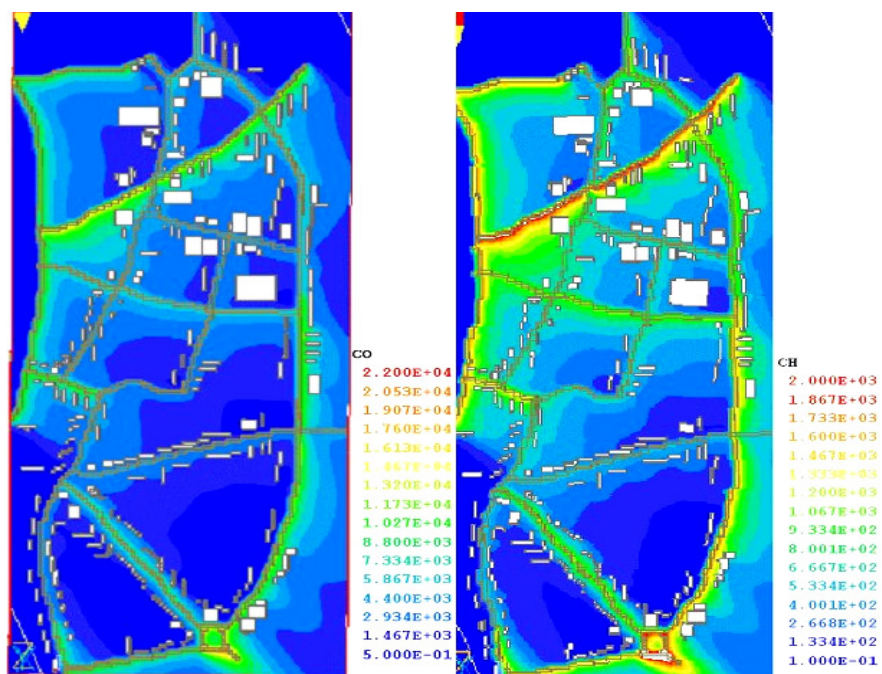
Fig. 6 . The result of scatter of CH x (CH) concentration 3 ( µ g/m ) in Žirmūnai when wind blows from the north west at 3 m/s speed